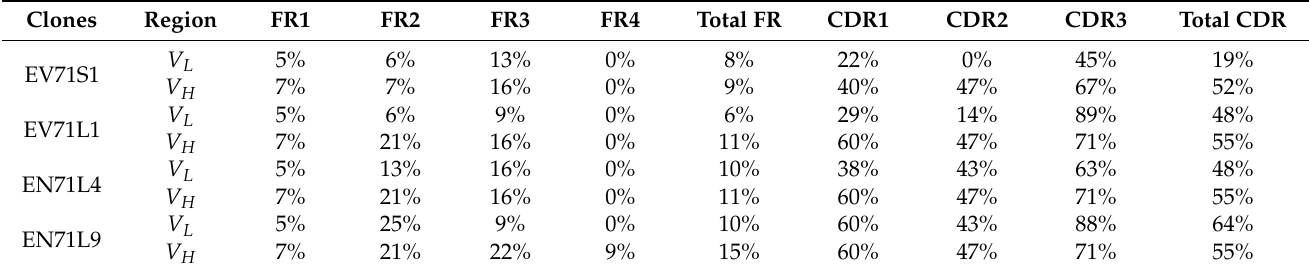
Table 2. Amino acid mutation rates of V L and V H genes used by scFv antibodies. Clones